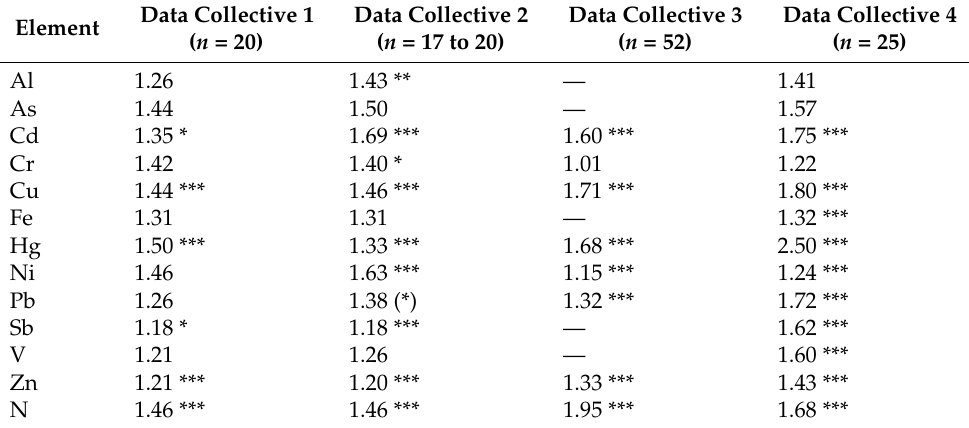
Table 7. Median ratios of elemental concentrations in moss samples collected below and beyond tree canopies based on the Moss Survey 2020 (data collectives 1 and 2), moss samplings in 2012 and 2013 (data collective 3) [27] and on the Moss Survey 2015 (data collective 4) [20]. Data Collective 1 Data Collective Element ( n = 20)